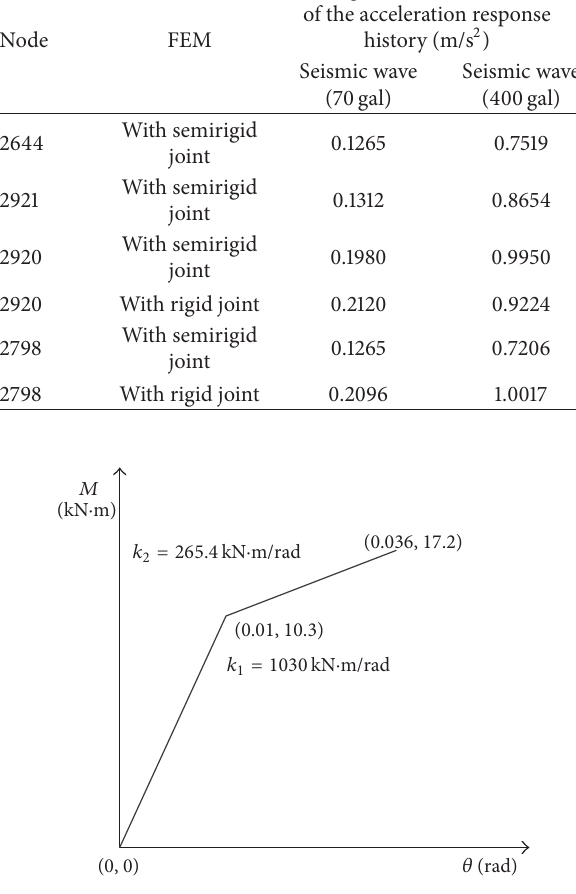
Figure 13: Moment-rotation relationship for 𝑘 𝜃𝑦 .